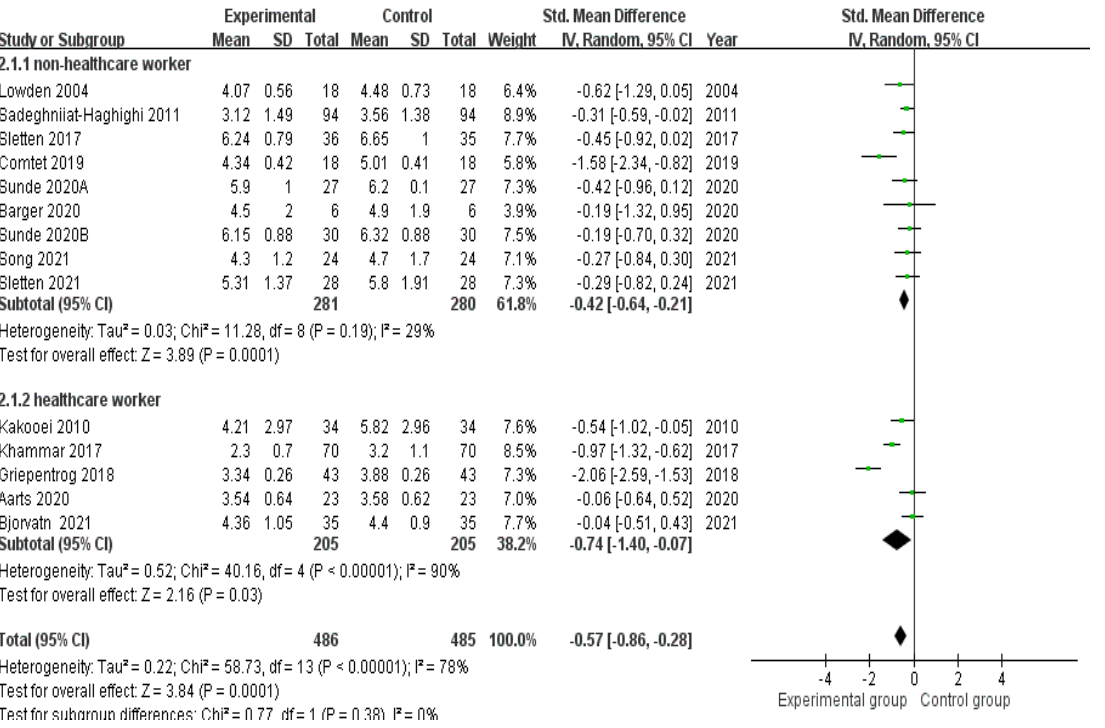
Figure 5. Effects of lighting interventions in improving the sleepiness of night-shift